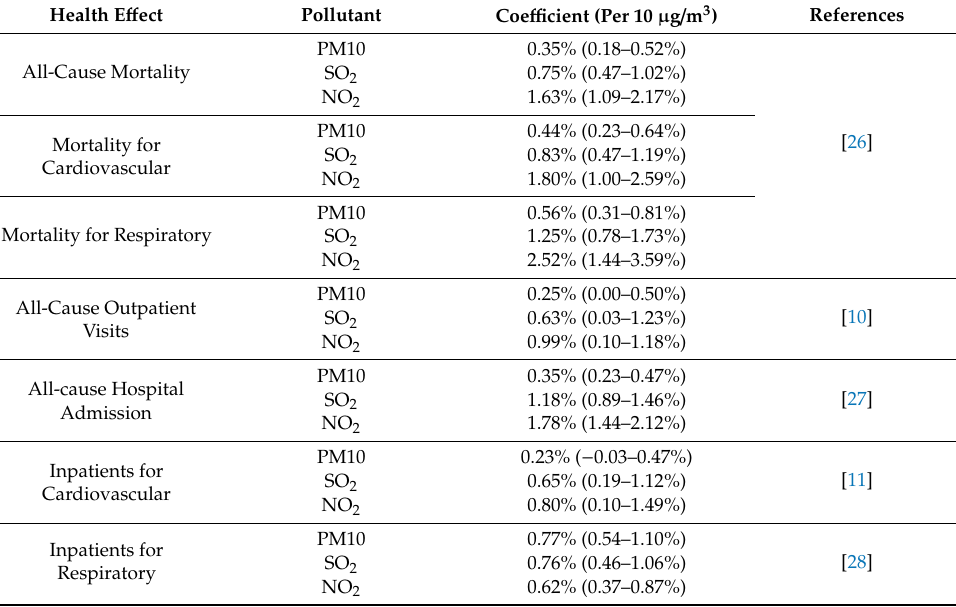
Table 1. Coe ffi cients of health e ff ect caused by ambient